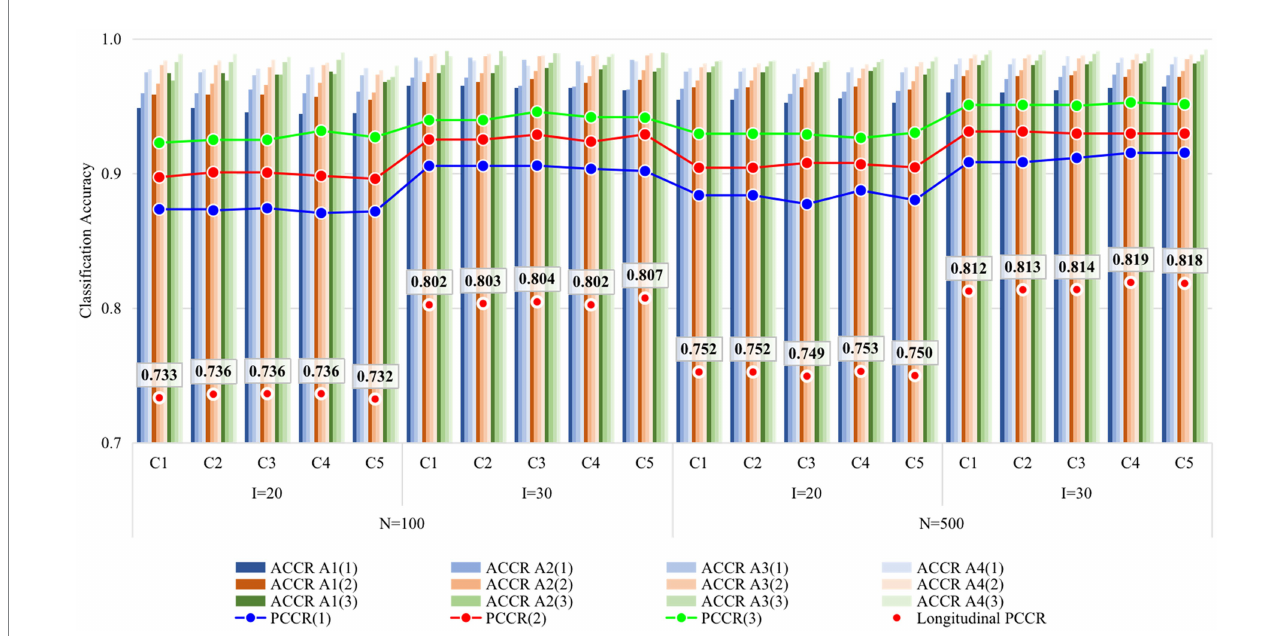
FIGURE 4 Recovery of attributes in Study 2. I, number of items; N, sample size; ACCR, attribute correct classification rate; PCCR, attribute pattern correct classification rate on each occasion (four attributes); LPCCR, PCCR on all three occasions (12 attributes); Occasion is in parentheses; C1, ratio of anchor items is 0%; C2, ratio of anchor items is 20%; C3, ratio of anchor items is 40%; C4, ratio of anchor items is 60%; C5, ratio of anchor items is 80%.